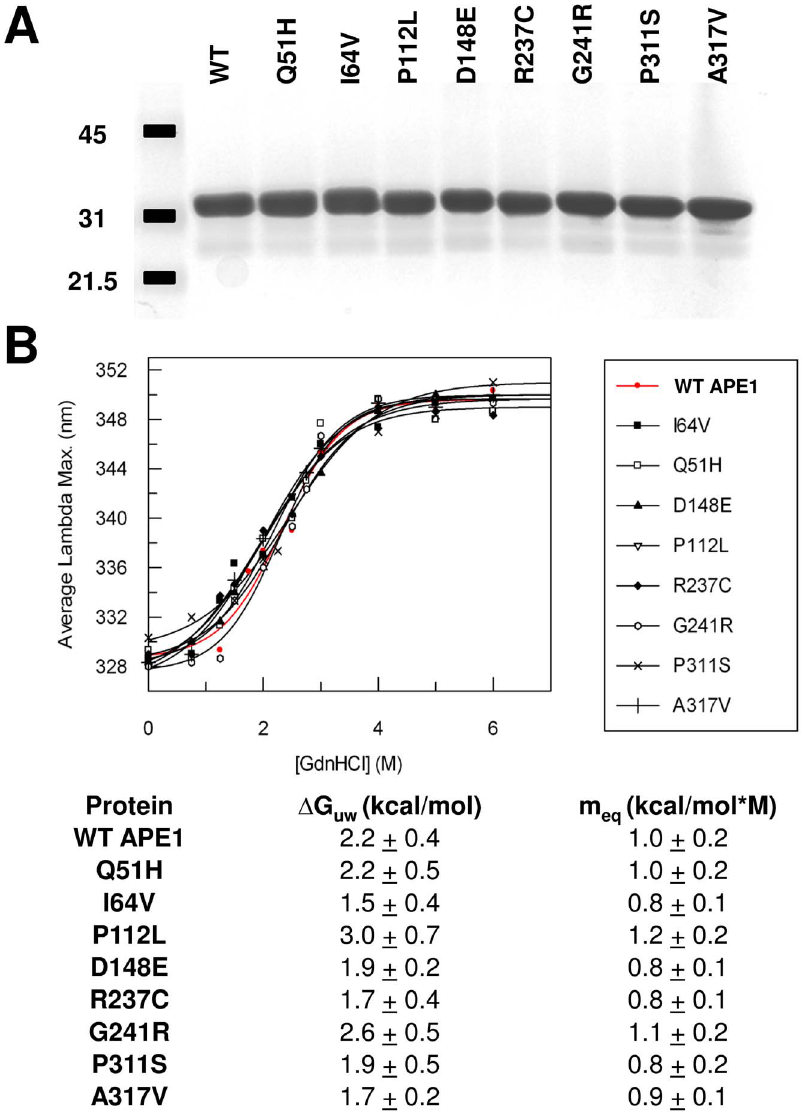
Figure 2. Variant proteins and thermodynamic stability of folding as determined by chemical denaturation. ( A ) Following purification, wild-type (WT) and variant APE1 proteins were quantified and analyzed (1 m g) by SDS-polyacrylamide gel electrophoresis and Coomassie blue staining. Shown is a representative gel image. Molecular mass standards are indicated to the left in kDa. ( B ) Profile of maximum wavelength emission for tryptophan fluorescence relative to GdnHCl concentration for the wild-type (WT) and variant APE1 proteins (top). The free energies of protein unfolding in the absence of denaturant ( D G uw ) and the values reflecting the dependence of the free energy on denaturant concentration (m eq ) are shown (bottom).